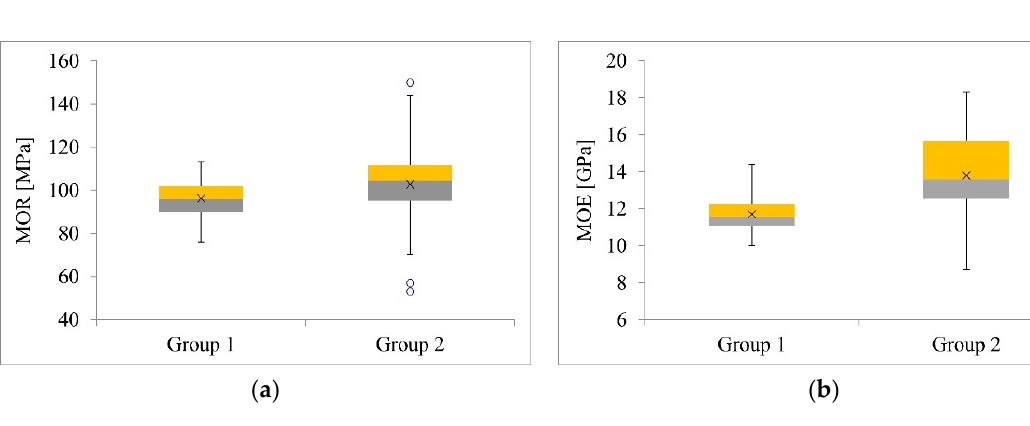
Figure 12. Box plots: ( a ) MOR, ( b ) MOE.